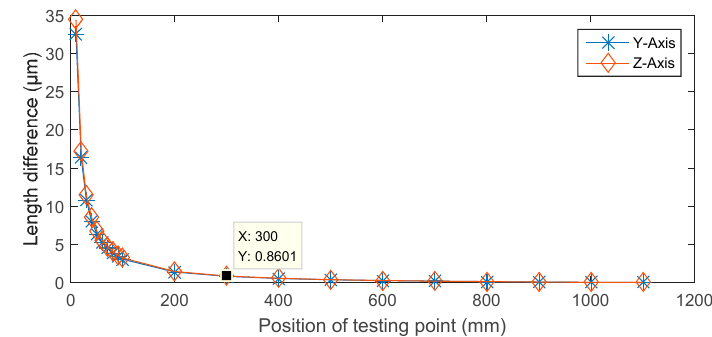
Figure 13. Simulation result of measurement length difference ( y ‐ and z ‐ axis).